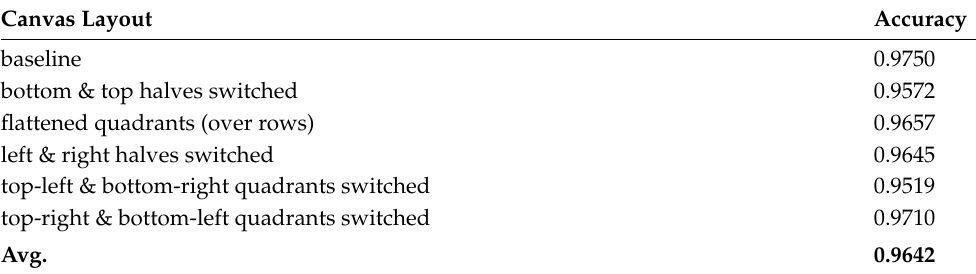
Table 10. Comparison between different canvas